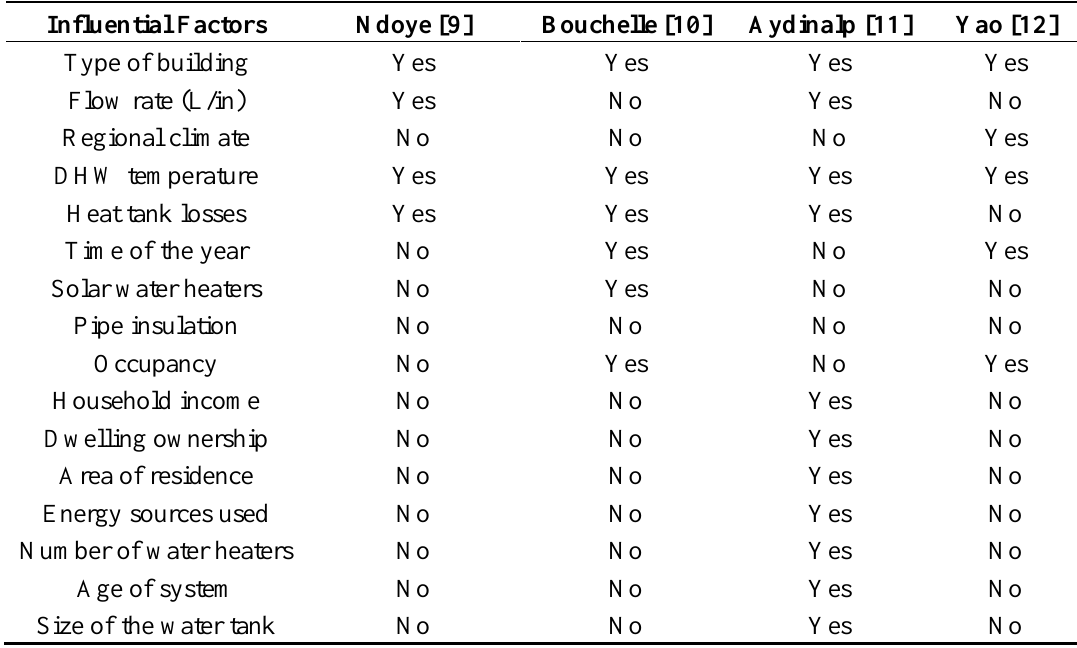
Table 3. Influential factors used in each research.